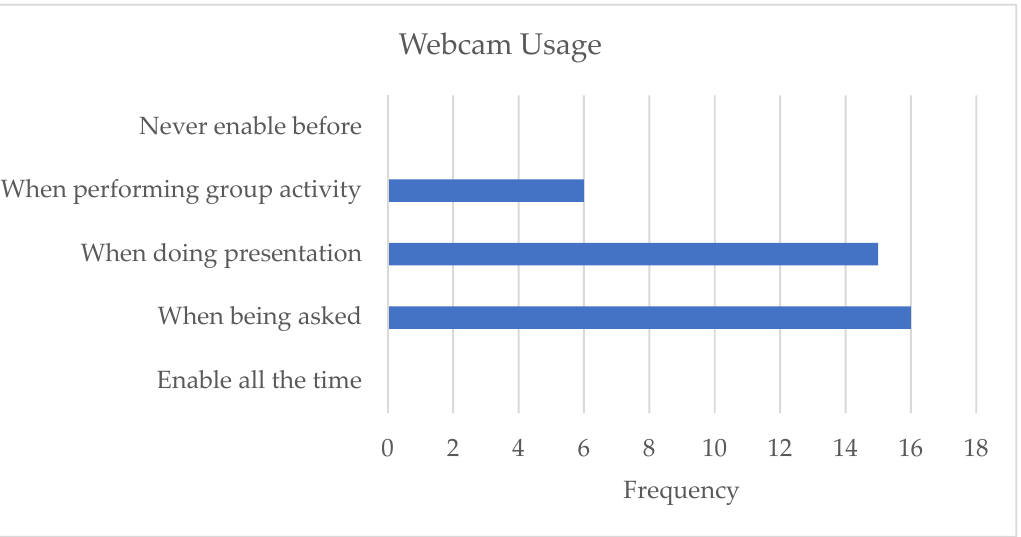
Figure 6. Bar chart of web camera usage during a video conference meeting. The usability study also asked participants how they felt when other group members’ web cameras were turned off while performing collaborative activities. The majority of the participants (69%) were neutral and impartial, meaning it did not matter to them if the web camera was switched on or off by other group members. Around 20% of the participants associated the web cameras being turned off with negative feelings, with 13% describing a sense of loneliness and isolation and another 6% describing feelings of boredom and demotivation. On the contrary, the remaining 12% of the participants